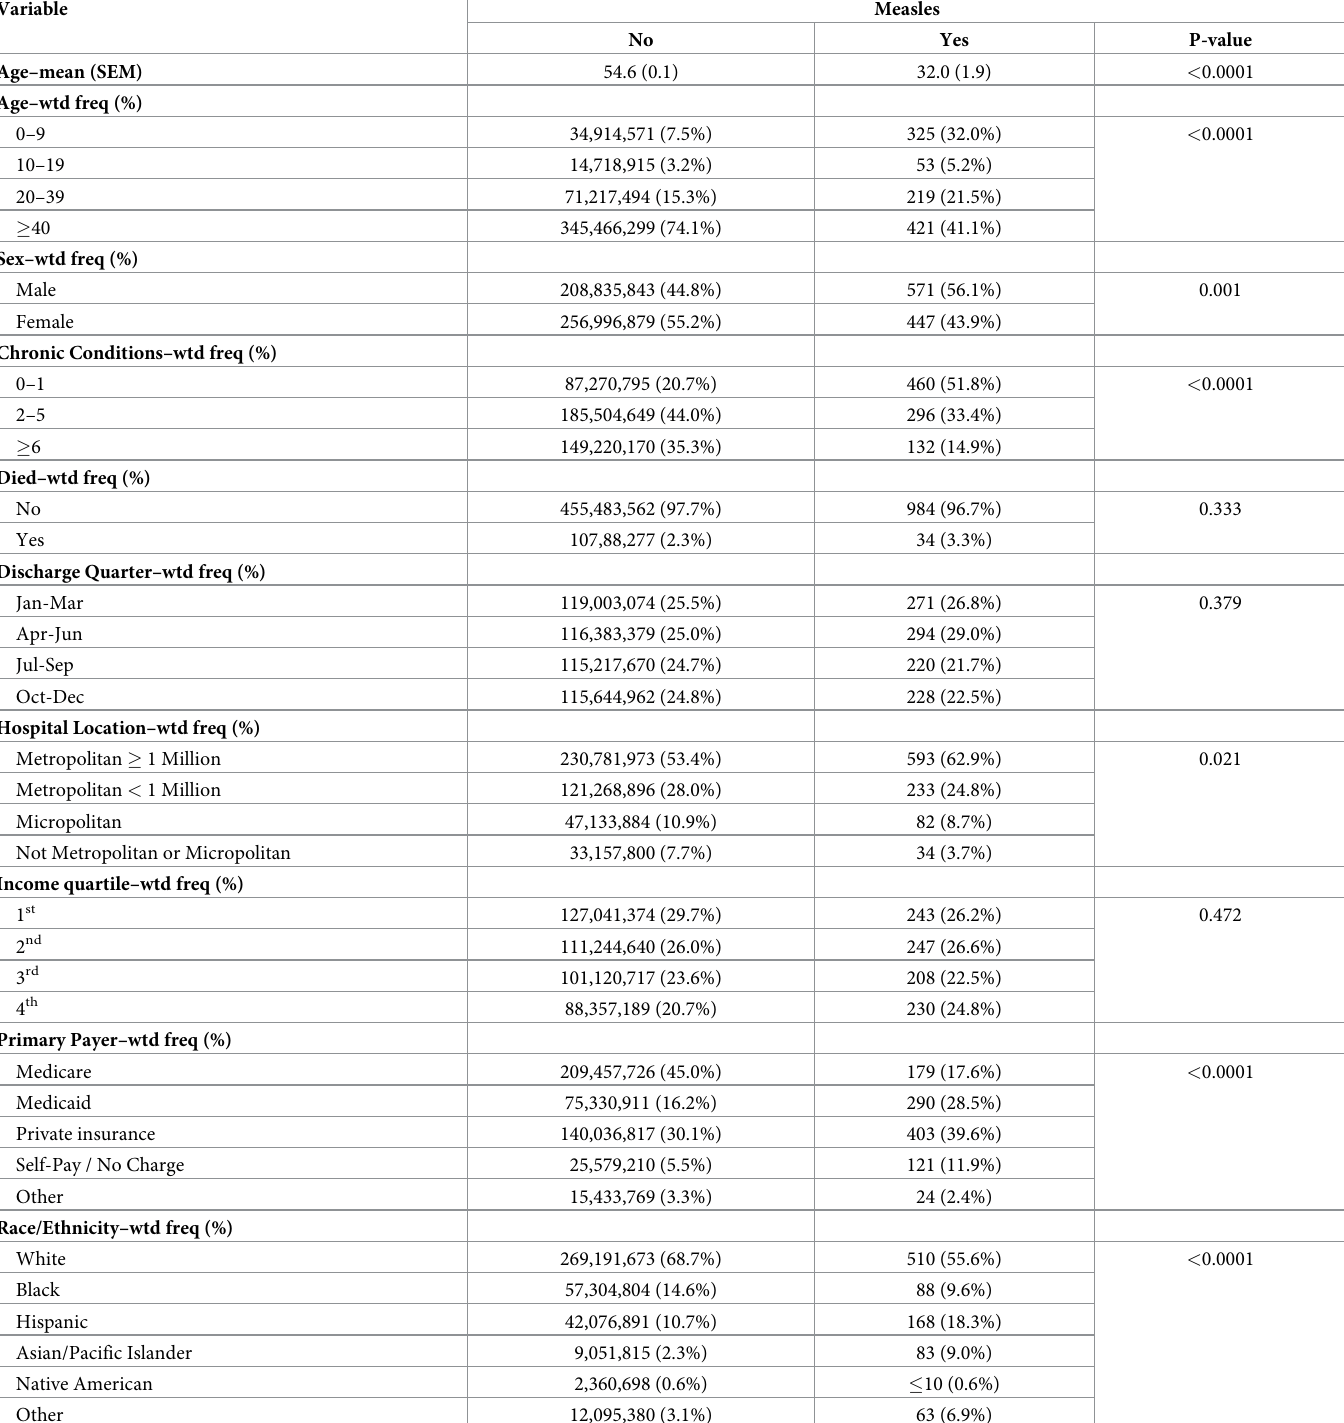
Table 1. Baseline characteristics of inpatients with and without